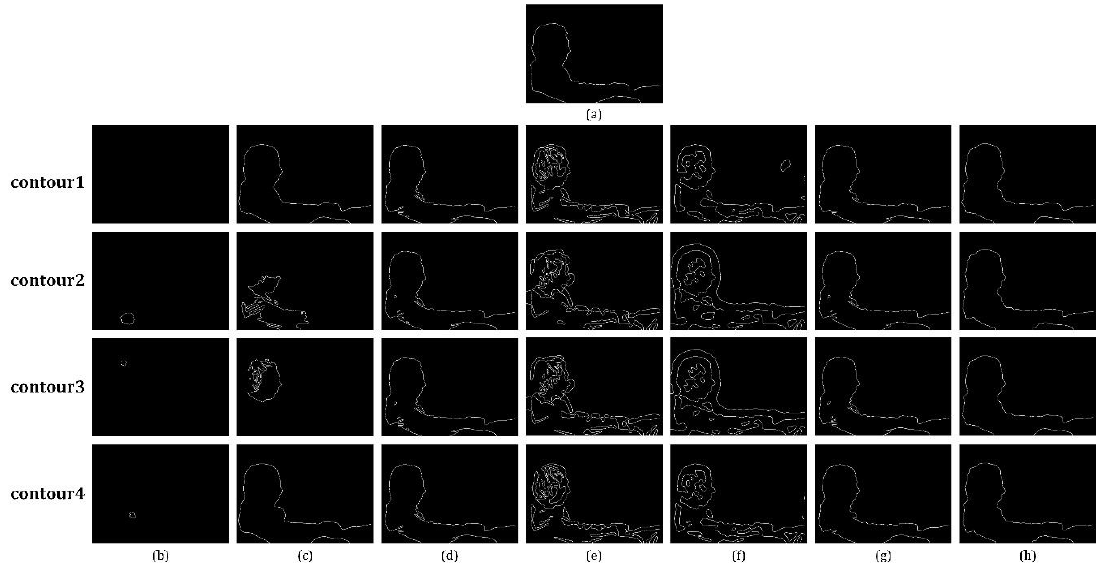
Figure 19. Binary segmentation results of ‘plane’ image: ( a ) ground truth; ( b ) GAC; ( c ) CV; ( d ) SBGFRLS; ( e ) LBF; ( f ) ILFE; ( g ) Cao’s model; ( h ) the proposed method.